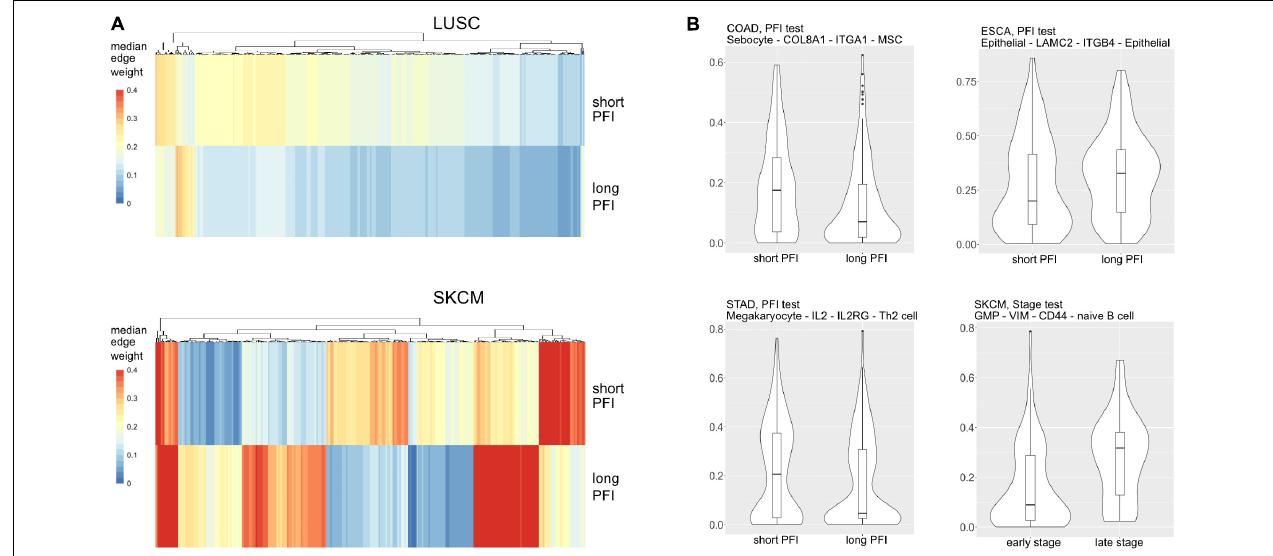
FIGURE 6 | (A) Median values for each differentially weighted cell-cell edge (DWE) for the progression-free interval (PFI) categories (in row, DWE edges in columns). (B) Examples of differentially weighted edges.